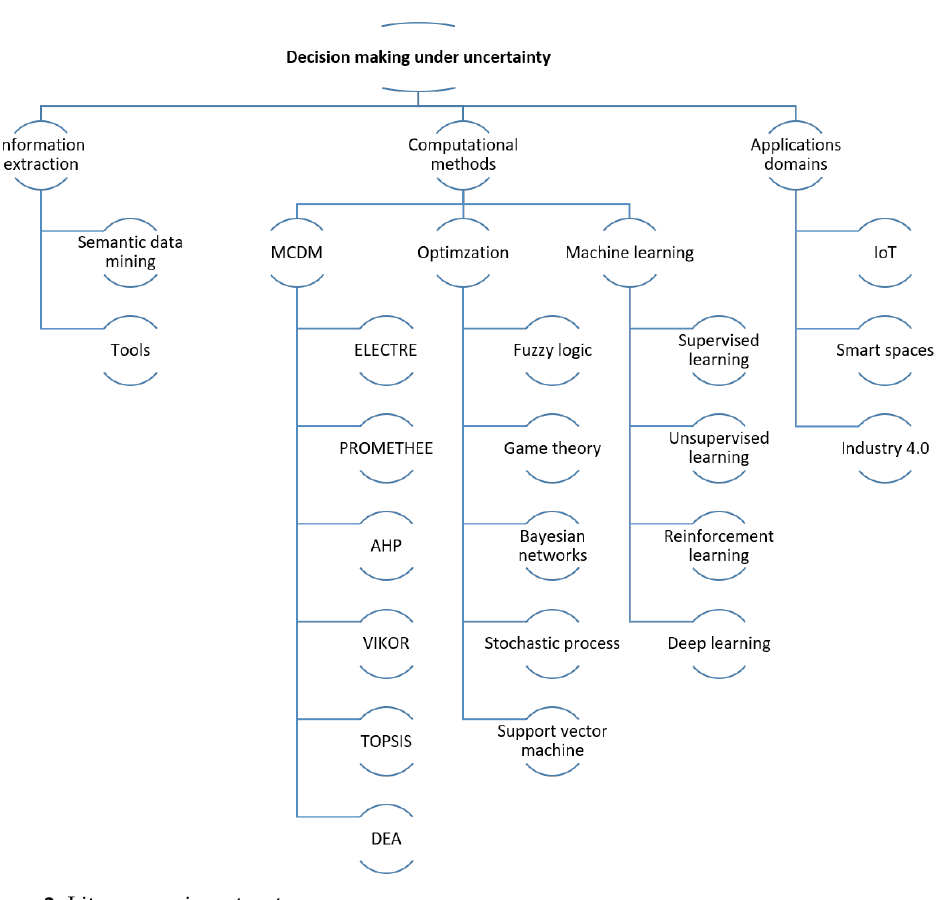
Figure 2. Literary review